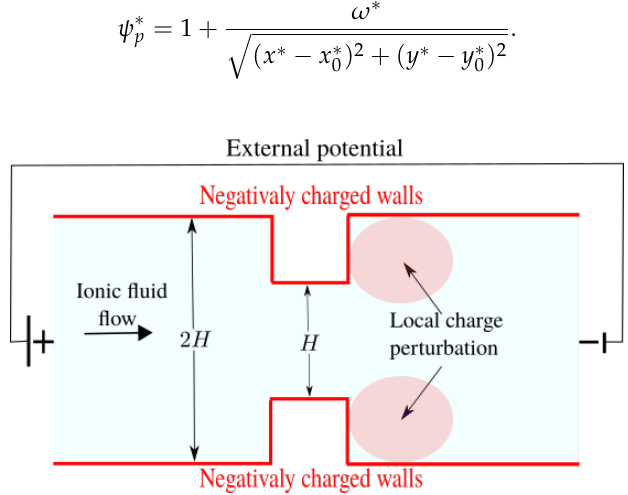
Figure 14. Illustration of imposed perturbation near the